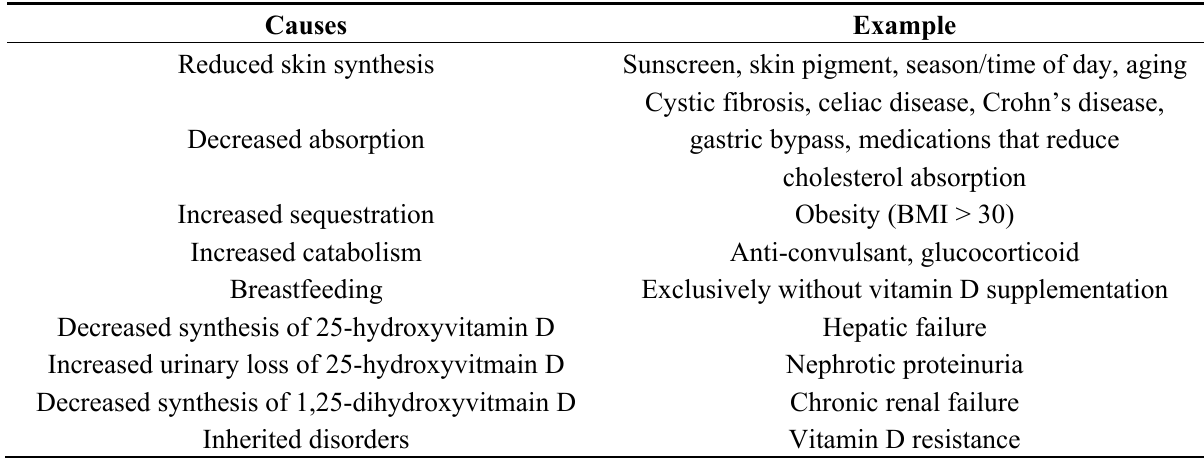
Table 4. Major causes of vitamin D deficiency